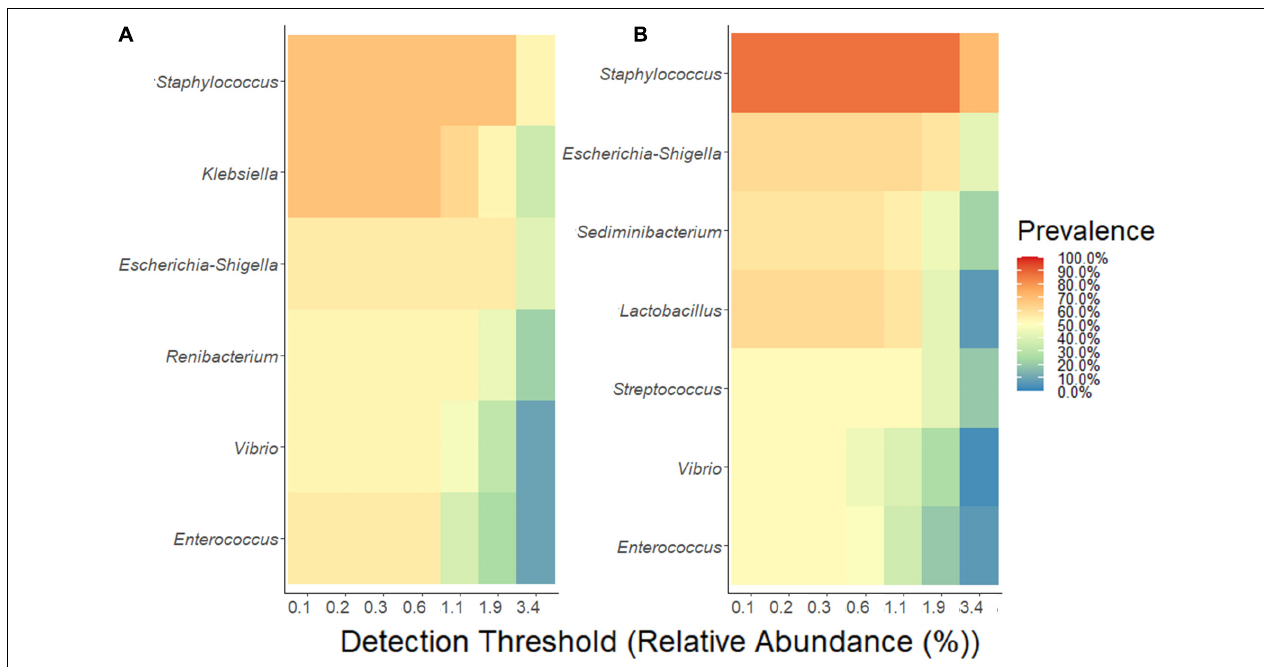
FIGURE 4 | Determination of core-taxa shared by (A) MOM/RM and (B) FMOM/FRM samples after 4 h of incubation. A minimum detection of 0.001 and a prevalence = 50/100 were used to define the